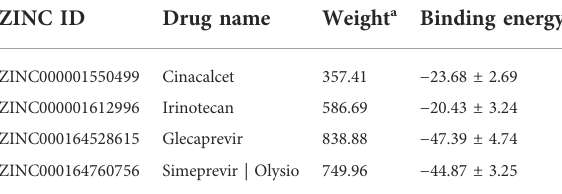
TABLE 1 Binding energies, derived from MM/GBSA calculation, of the top two compounds selected in virtual screening for GPR160 and CRHR2